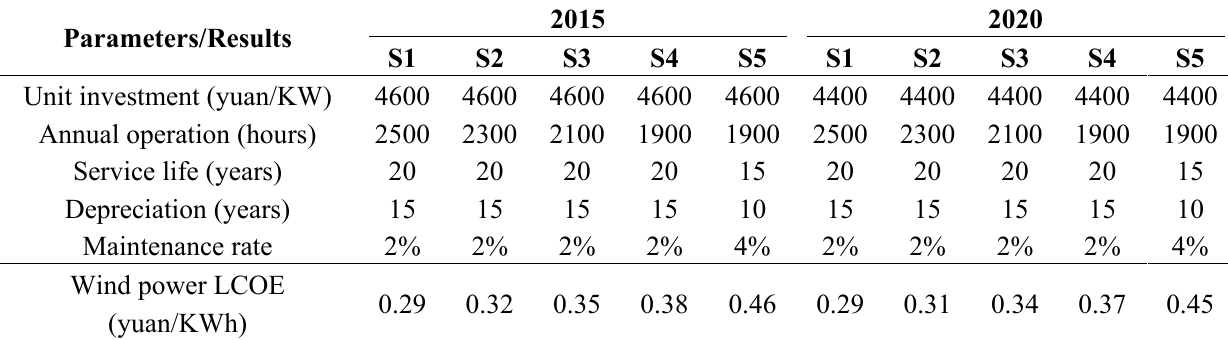
Table 8. Estimated LCOE levels of wind power in China, 2015 and 2020